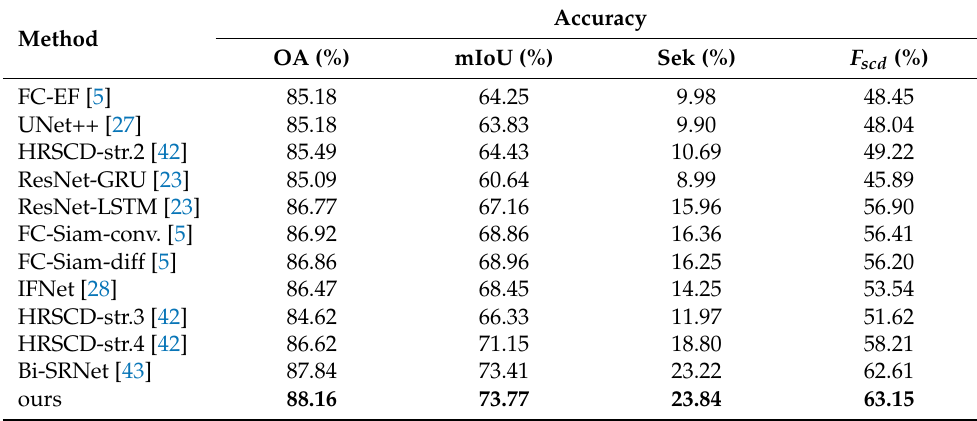
Table 2. Comparison of the proposed methods with literature methods for the SCD. F scd is a new metric introduced by